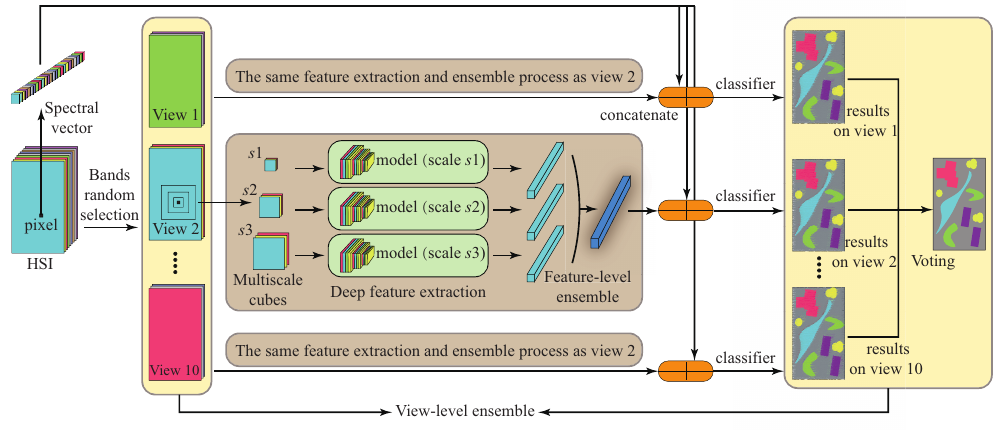
Figure 2. Illustration of feature learning and classification based on ensemble learning strategies of the proposed method. The symbols s 1, s 2 and s 3 represent different spatial